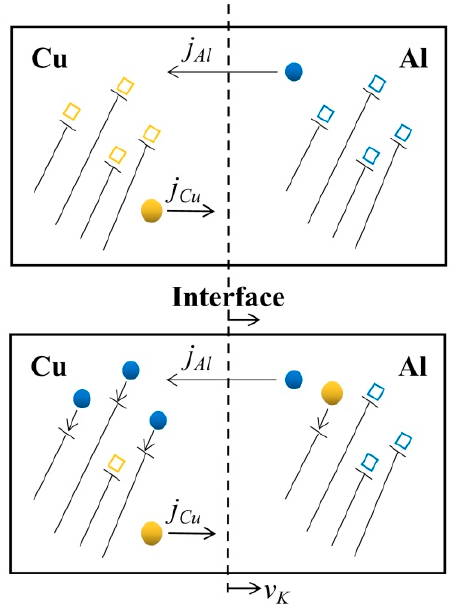
Figure 15. Kirkendall effect dominates element diffusion [170].